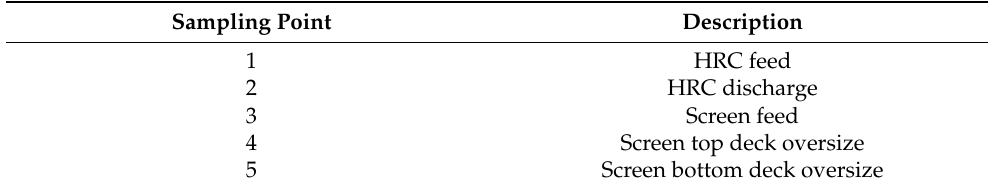
Table 3. Sampling point